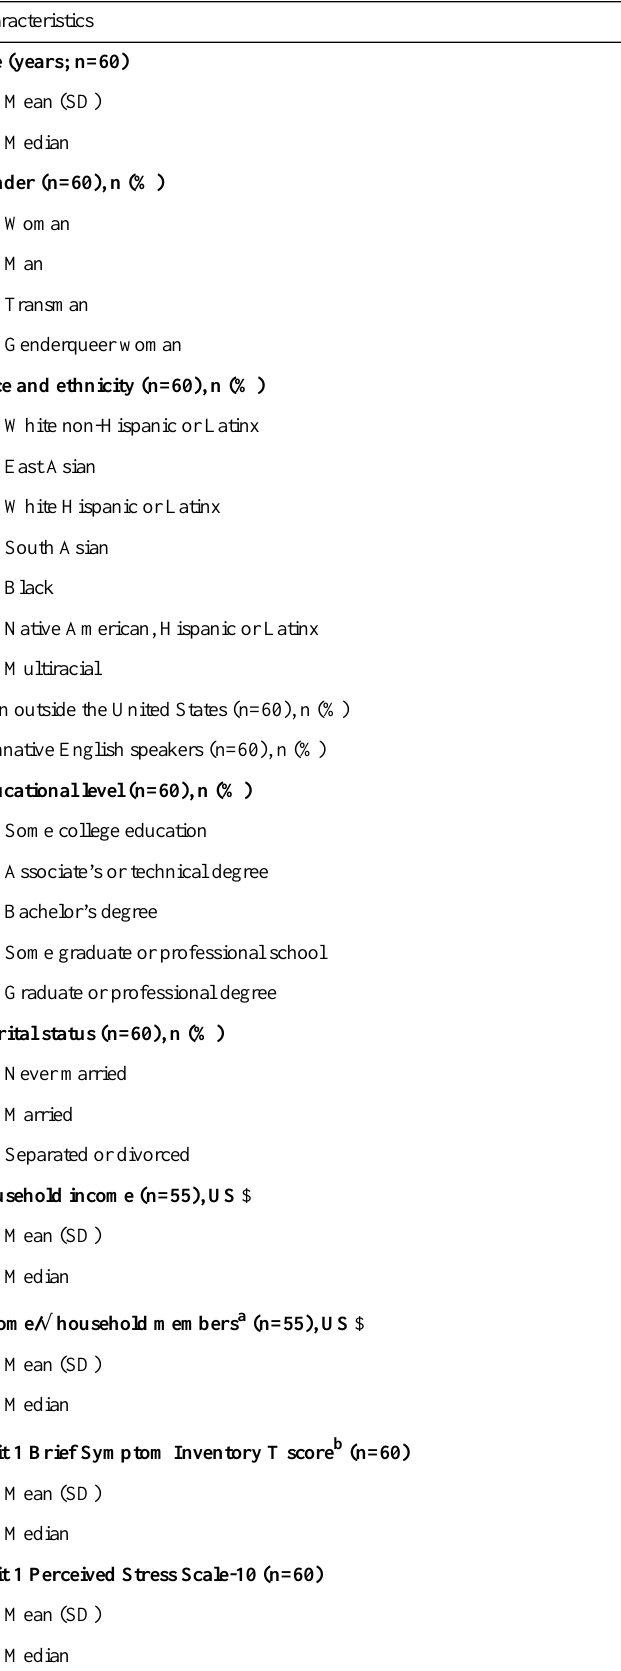
Table 1. Baseline demographic and clinical